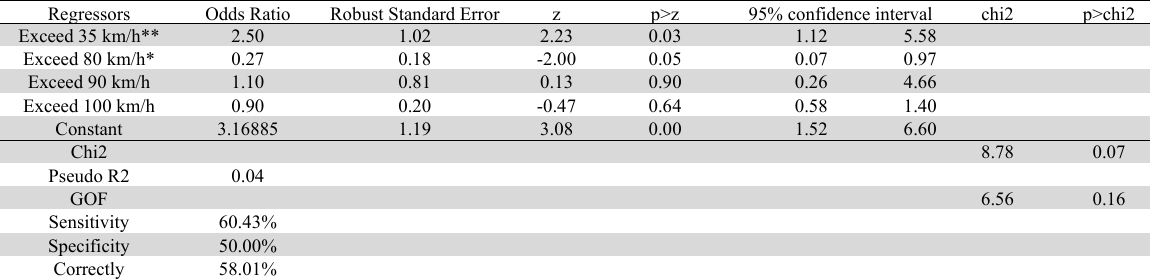
Logit regression for South Pan American